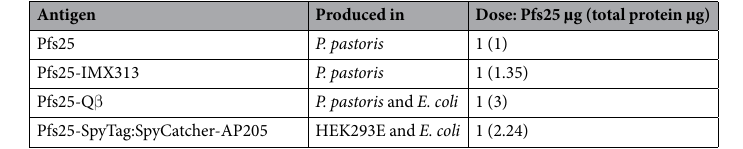
Table 1. Vaccine origin and dose